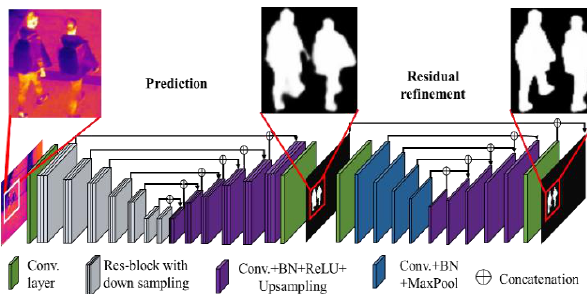
Figure 2. Architecture of the boundary-aware saliency map detection network BASNet.